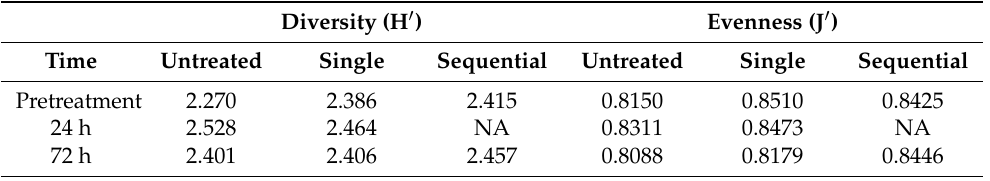
Table 1. Shannon Diversity Index results highlight genus-level community diversity and evenness before and after algaecide